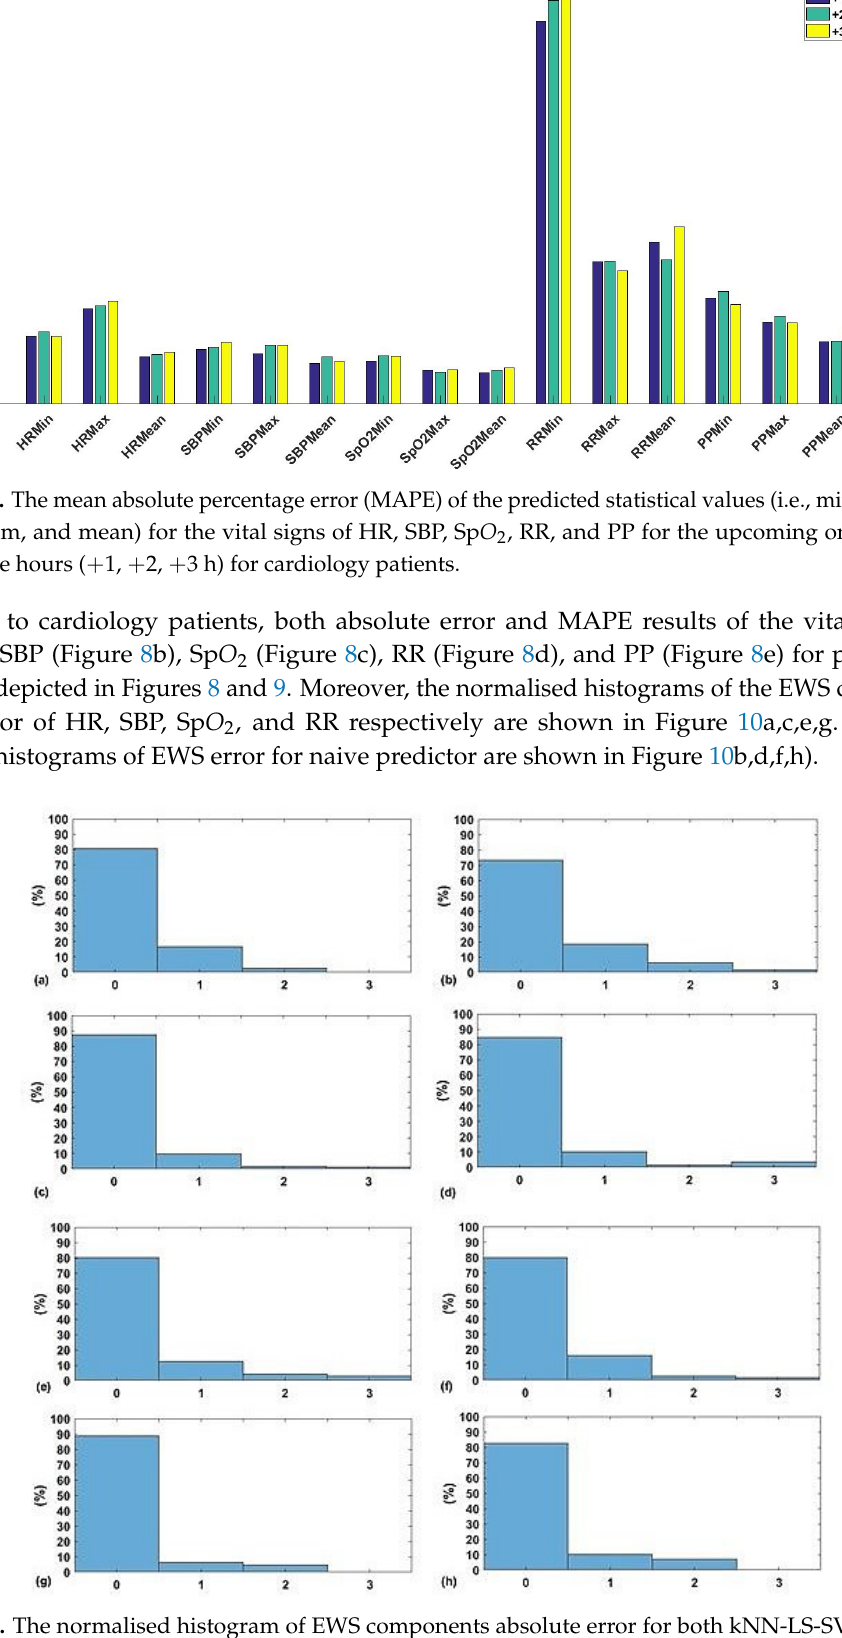
Figure 7. The normalised histogram of EWS components absolute error for both kNN-LS-SVM and Nieve predictors respectively of ( a , b ) HR, ( c , d ) SBP, ( e , f ) Sp O 2 , and ( g , h ) RR for cardiology